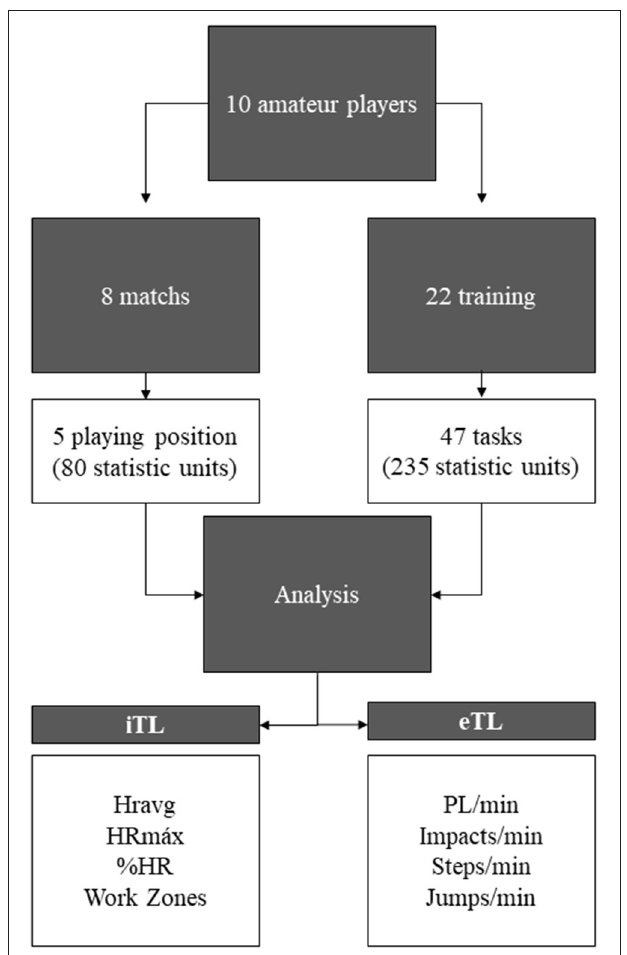
FIGURE 1 | Methods flow